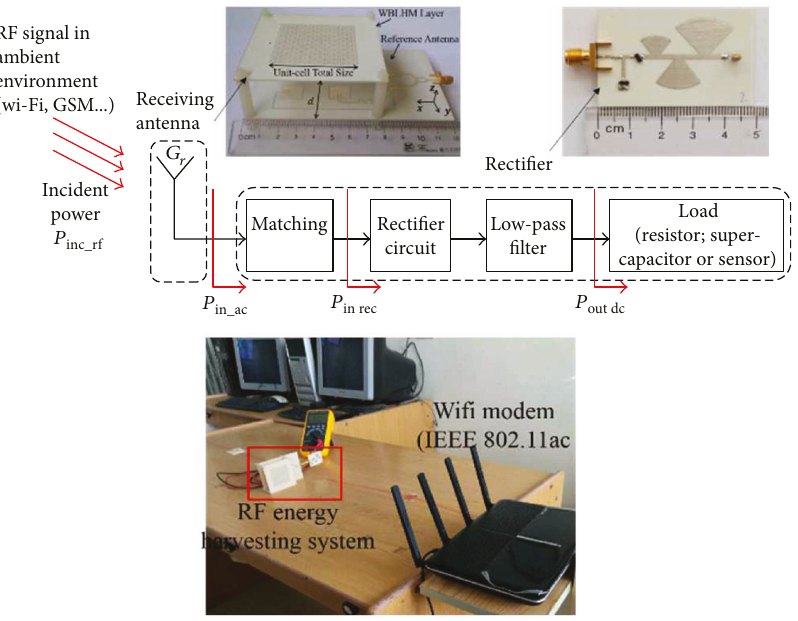
Figure 10: Wi-Fi energy harvesting system using WB CP LHM antenna.